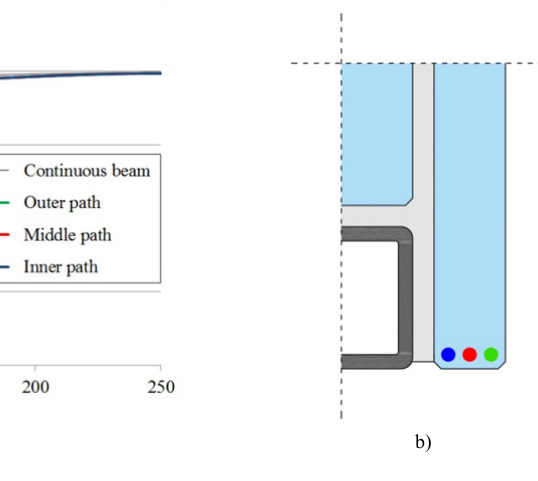
Fig. 10 Tensile stress collected along three different paths.